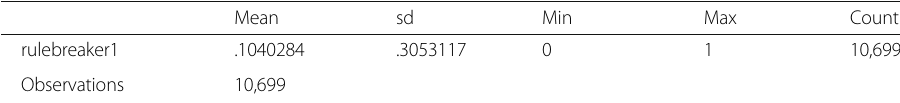
Table 2 Summary statistics for the hired pool (Continued)